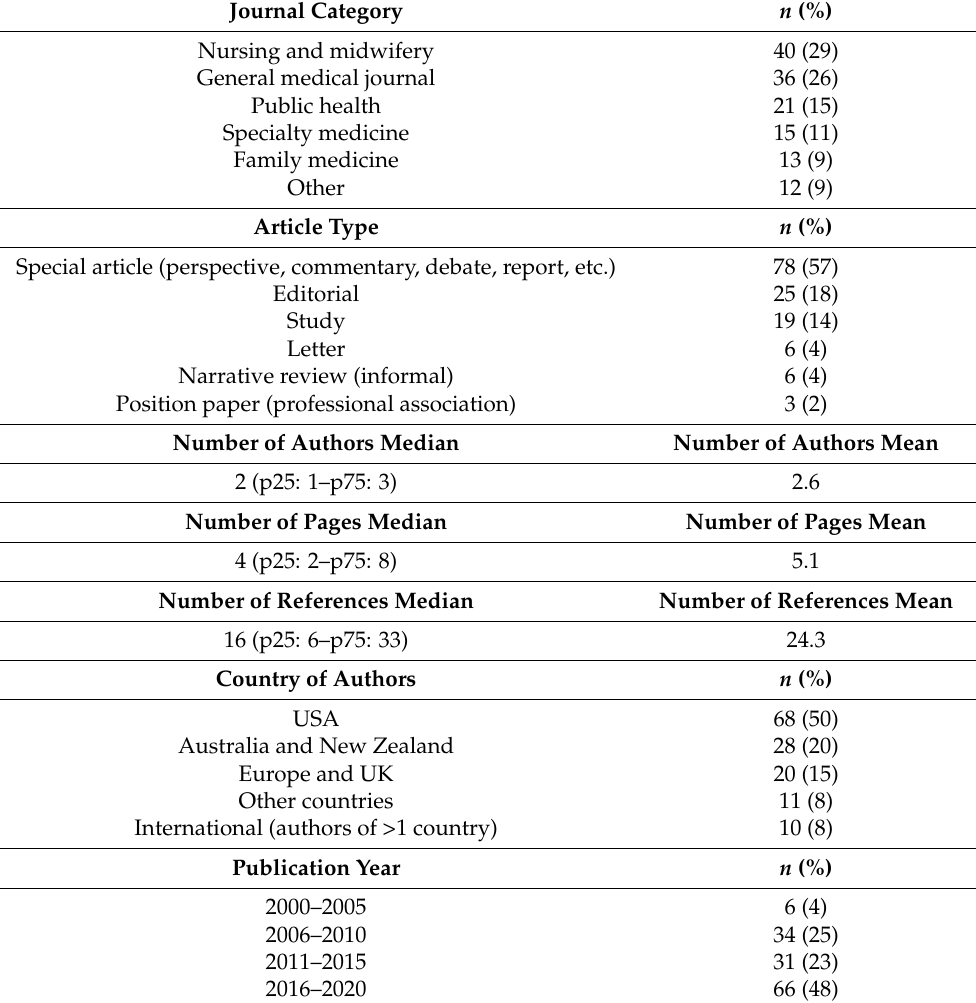
Table 1. Description of the typology of 137 included